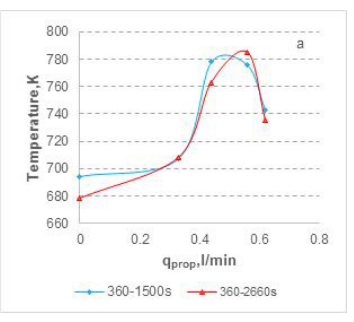
Figure 4. Volume fraction of CO 2 versus the injection of